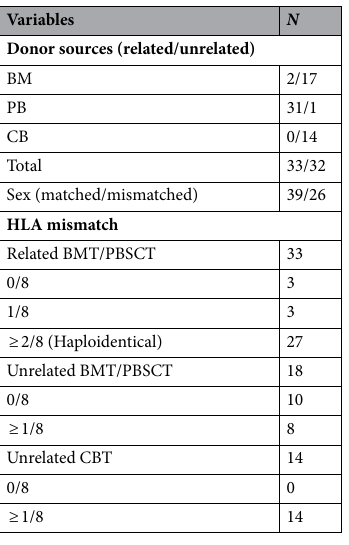
Table 1. Donor/recipient